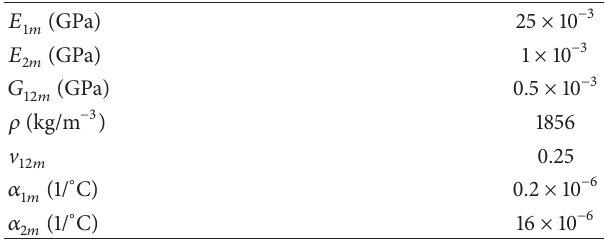
Table 2: The material parameters of